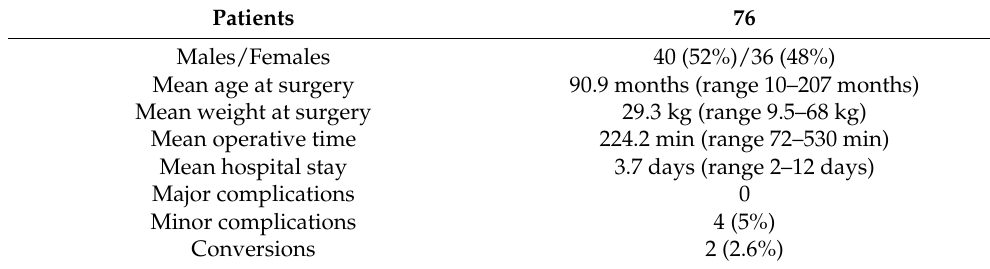
Table 1. Study population data.